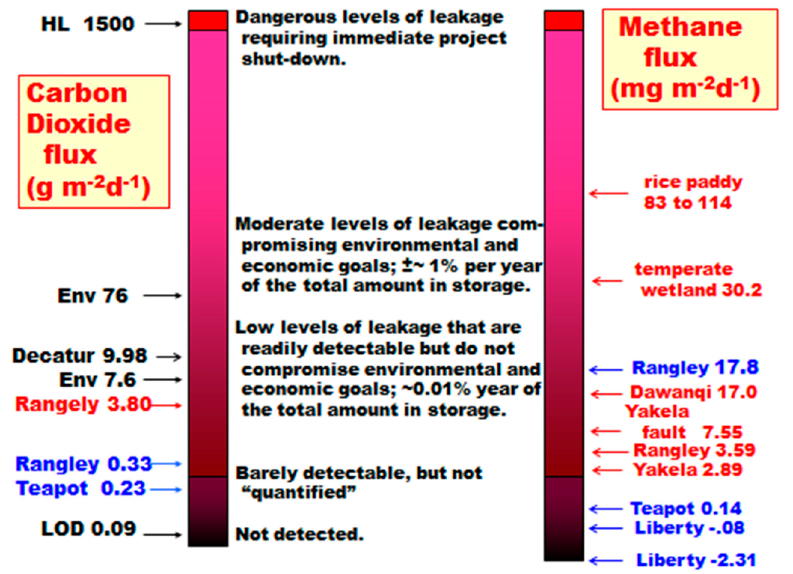
Figure 17. Carbon dioxide and methane flux levels observed in a selection of studies (summer data in red; winter data in blue; vertical axes not to scale).